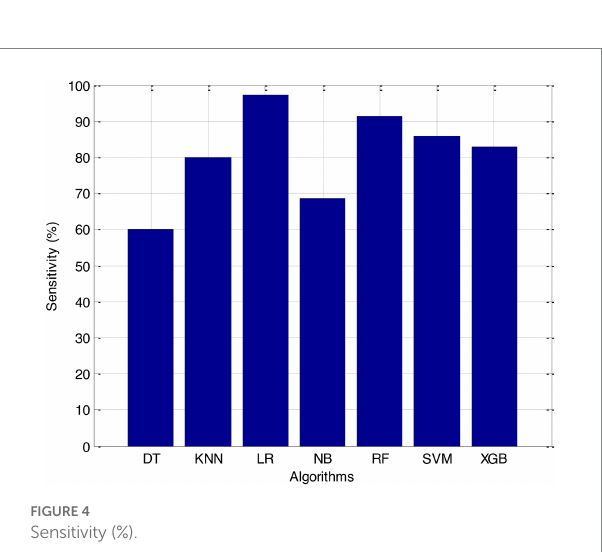
FIGURE 4 Sensitivity (%).